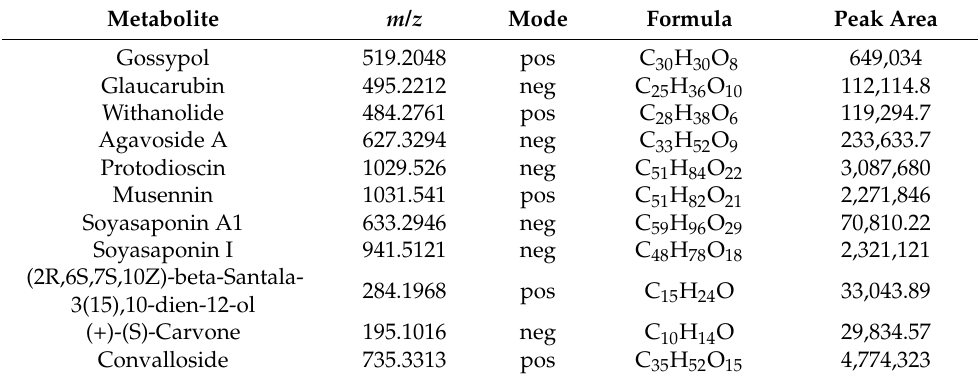
Table 2. Terpenoids in J-15-Ms.